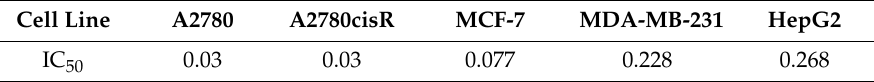
Figure 1. Structure of [( η 6 - p -MeC 6 H 4 Pr i ) 2 Ru 2 ( µ 2 -SC 6 H 4 - p -Bu t ) 3 ]Cl (DiRu-1). Table 1. IC 50 ( µ M) of DiRu-1 against various cancer cell lines